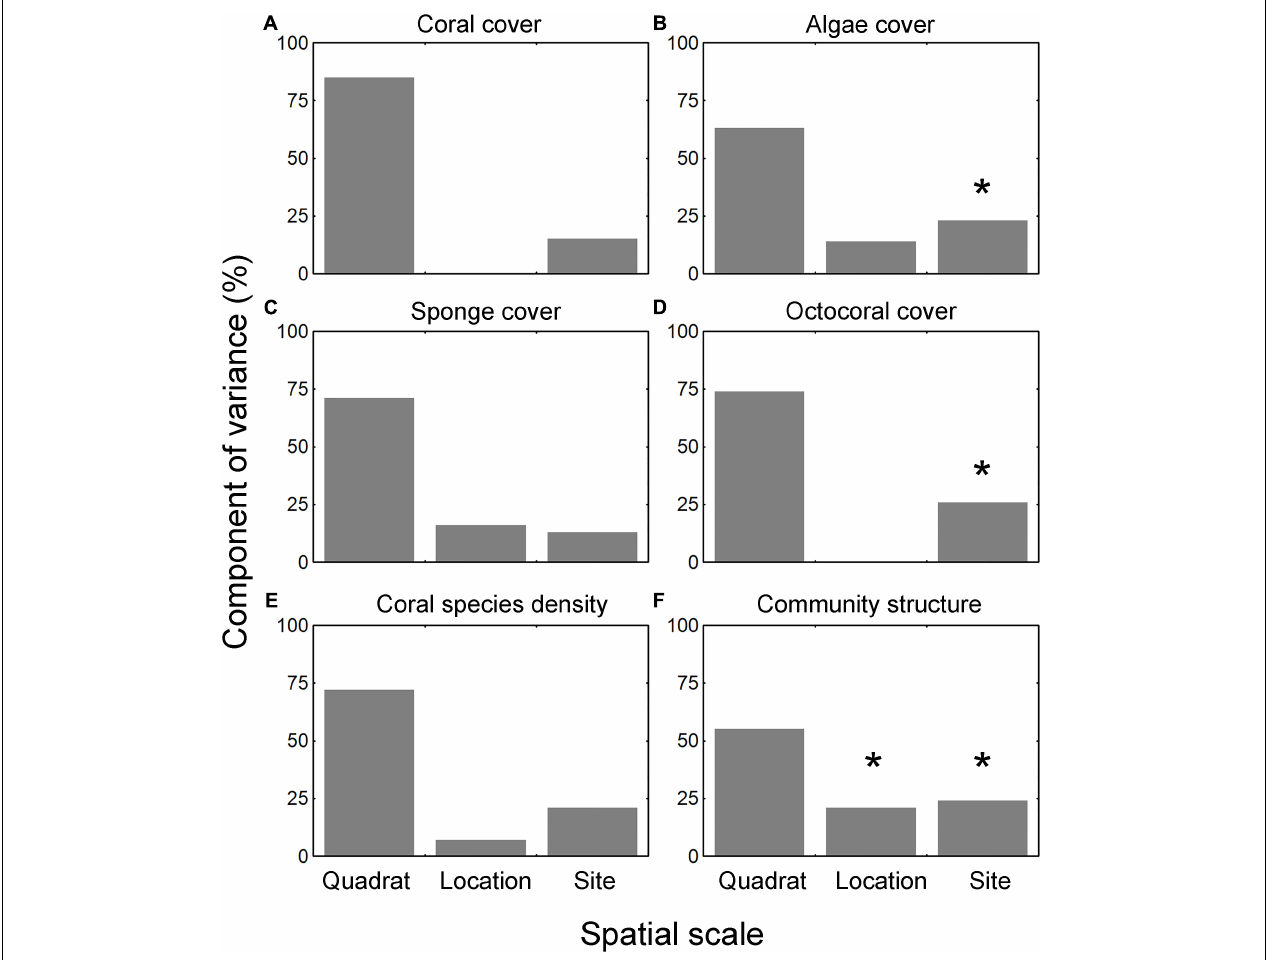
FIGURE 3 | Component of variance (CV) of all the community metrics after spatial scales, including (A) coral cover, (B) algae cover, (C) sponge cover, (D) octocoral cover, (E) coral species richness, and (F) coral species composition. CVs are estimated from the PERMANOVA; the degrees of freedom in the design were 12 for site, 13 for location nested within site, 234 for residual, and 259 for total. ∗ Indicates significant effect at p <